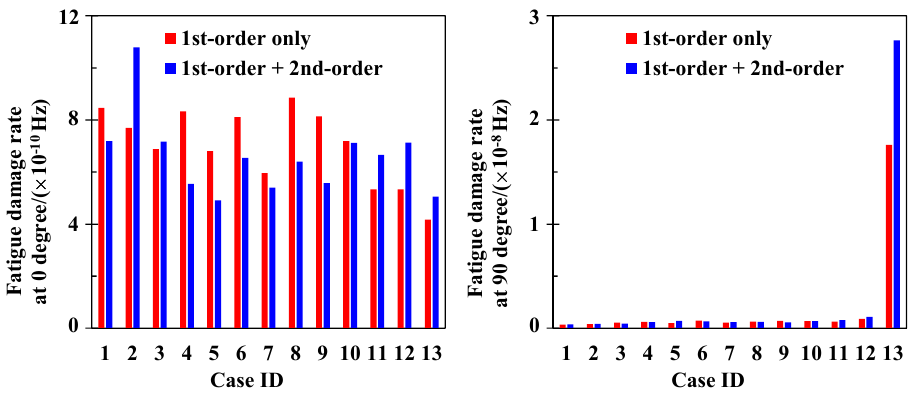
Figure 13. Fatigue damage rate at different tower-base locations of each load case.